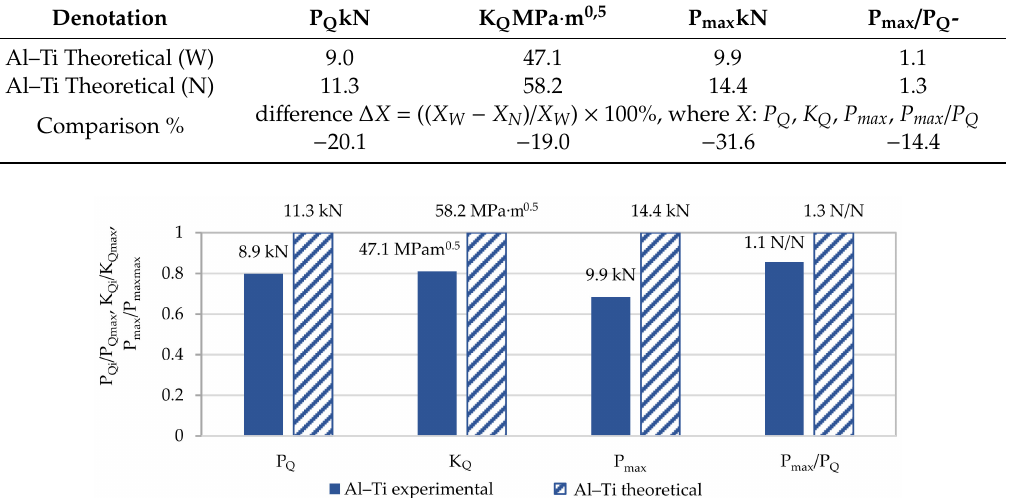
Figure 15. Normalized to 1 comparison of selected mechanical properties obtained from experiment and calculations characterizing fracture toughness of Al–Ti layered material in ambient conditions.